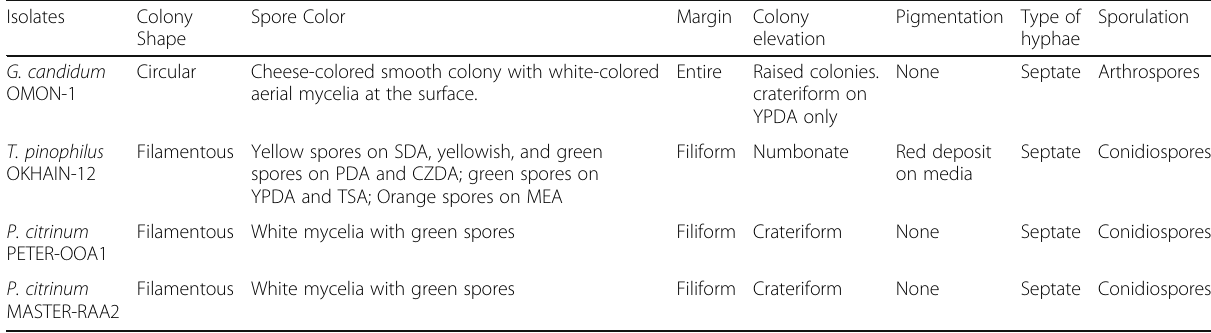
Pigmentation Type of Sporulation elevation hyphae Entire Raised colonies. None Septate Arthrospores crateriform on YPDA only